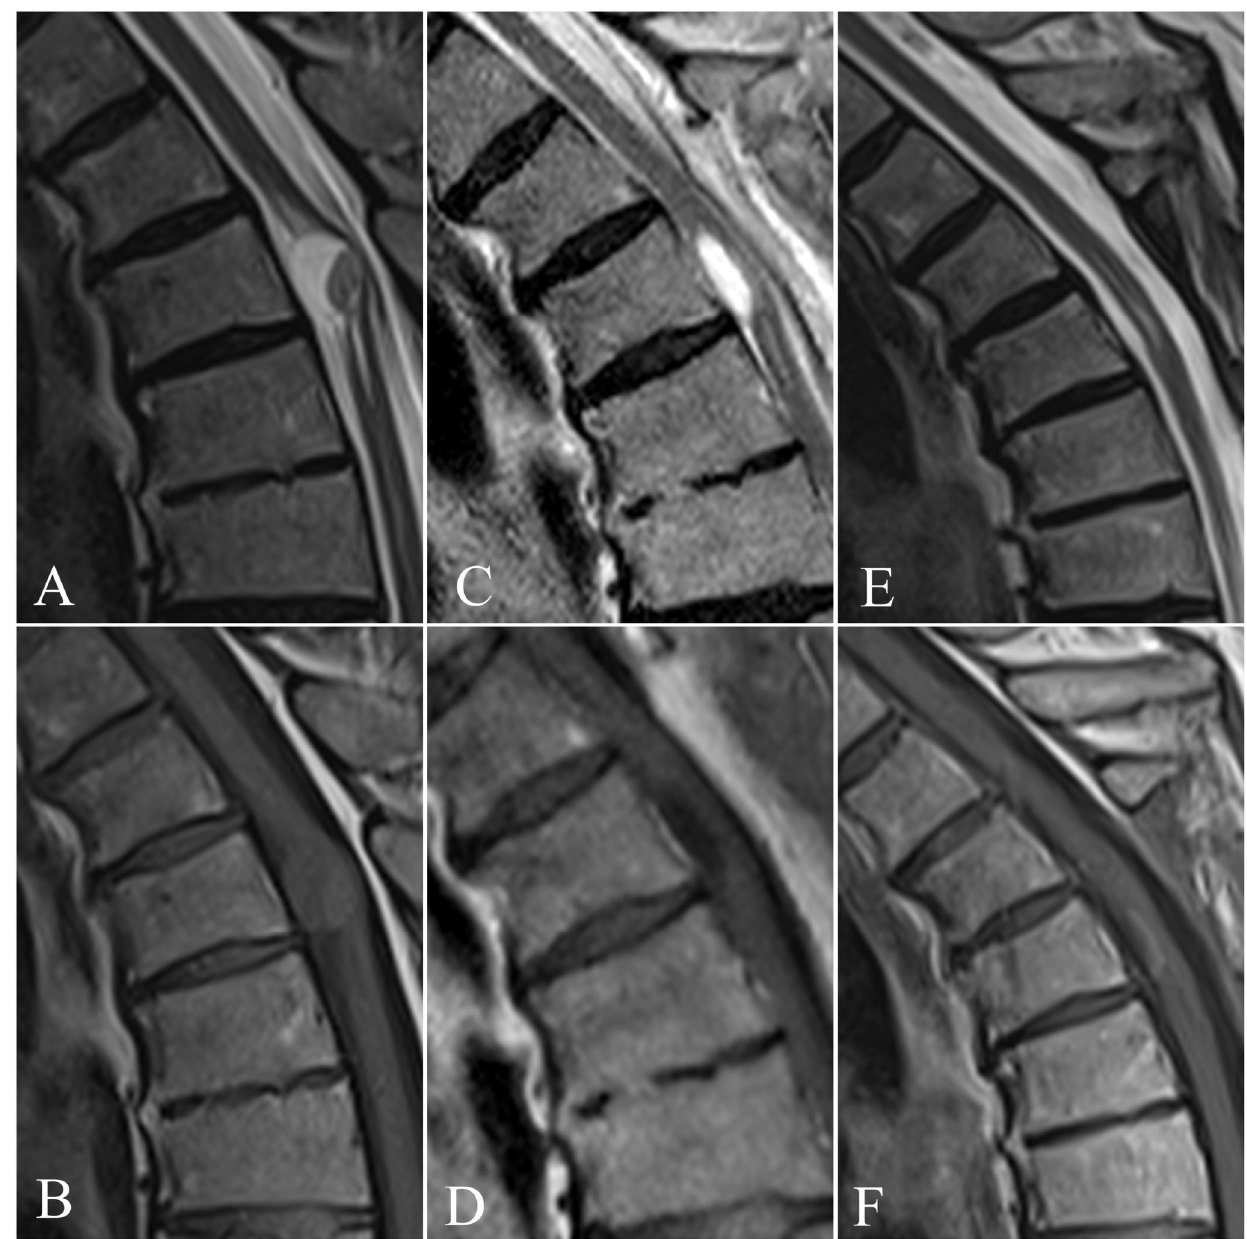
Figure 1. Magnetic resonance imaging (MRI) showing the sagittal scans: ( A ) T2-weighted image and ( B ) T1-weighted images of an expansile intramedullary solid-cystic lesion measuring 16 mm × 11 mm × 10 mm, without contrast enhancement, at the T4 level, with segmental widening of the spinal cord above and below the lesion. The early follow-up MRI shows no pathological mass and postoperative changes on both ( C ) T1-weighted and ( D ) T2-weighted images. The MRI performed 6 months after surgery revealed complete abscess excision in ( E ) T2-weighted and ( F ) T1-weighted sequences.